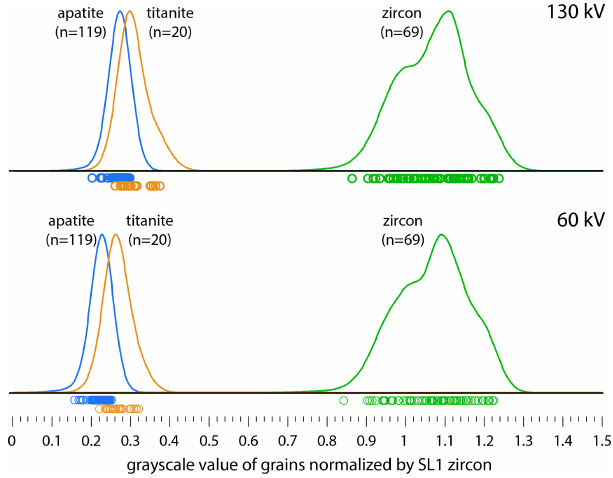
Figure 4. Kernel density estimates (KDEs) of all apatite, zircon, and titanite grayscale value measurements (including standards) for 68min scans calculated with an adaptive bandwidth equal to the standard deviation of grayscale variation within each grain. Each KDE is an aggregation of data from three different sample mounts and shows all individual data points. The grayscale value of each grain was normalized by the average grayscale value of SL1 zircon grains in the same volume. The difference between the attenuation of the three minerals is greater at 60kV than at 130kV, as theoreti- cally